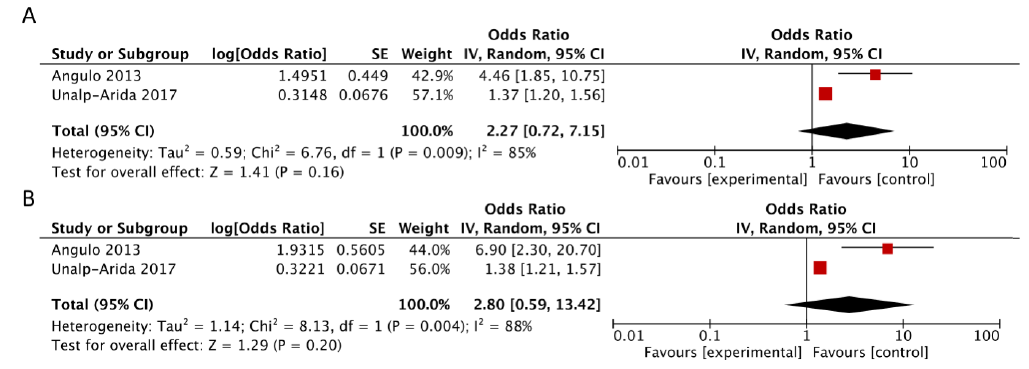
Figure 5. Forest plot of summary relative risks (RRs) of mortality ( A ) for high versus low-intermediate FIB-4 and ( B ) for high versus low FIB-4.